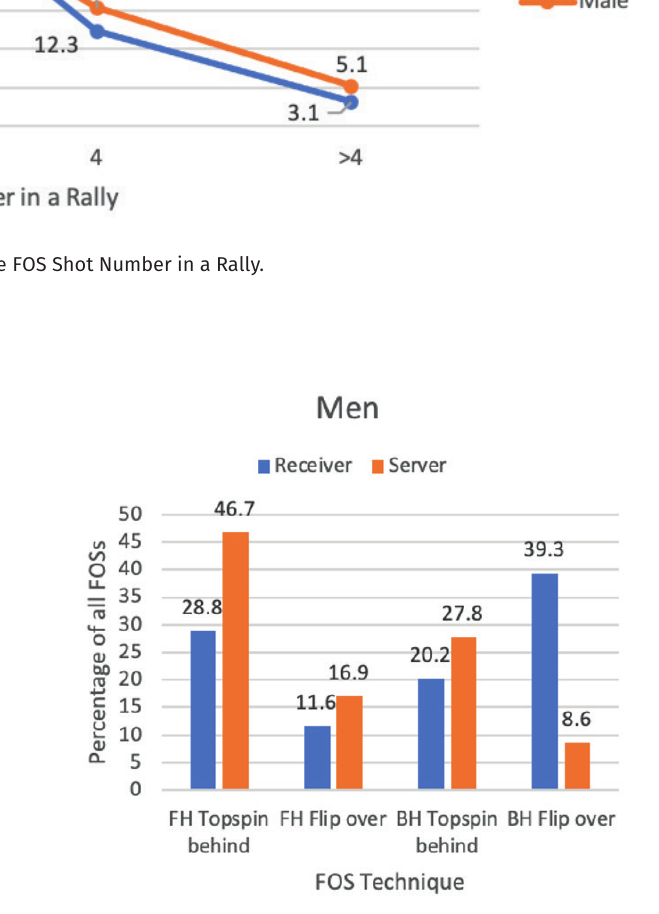
Figure 3. Distribution of FOSs separated by server/receiver for women.